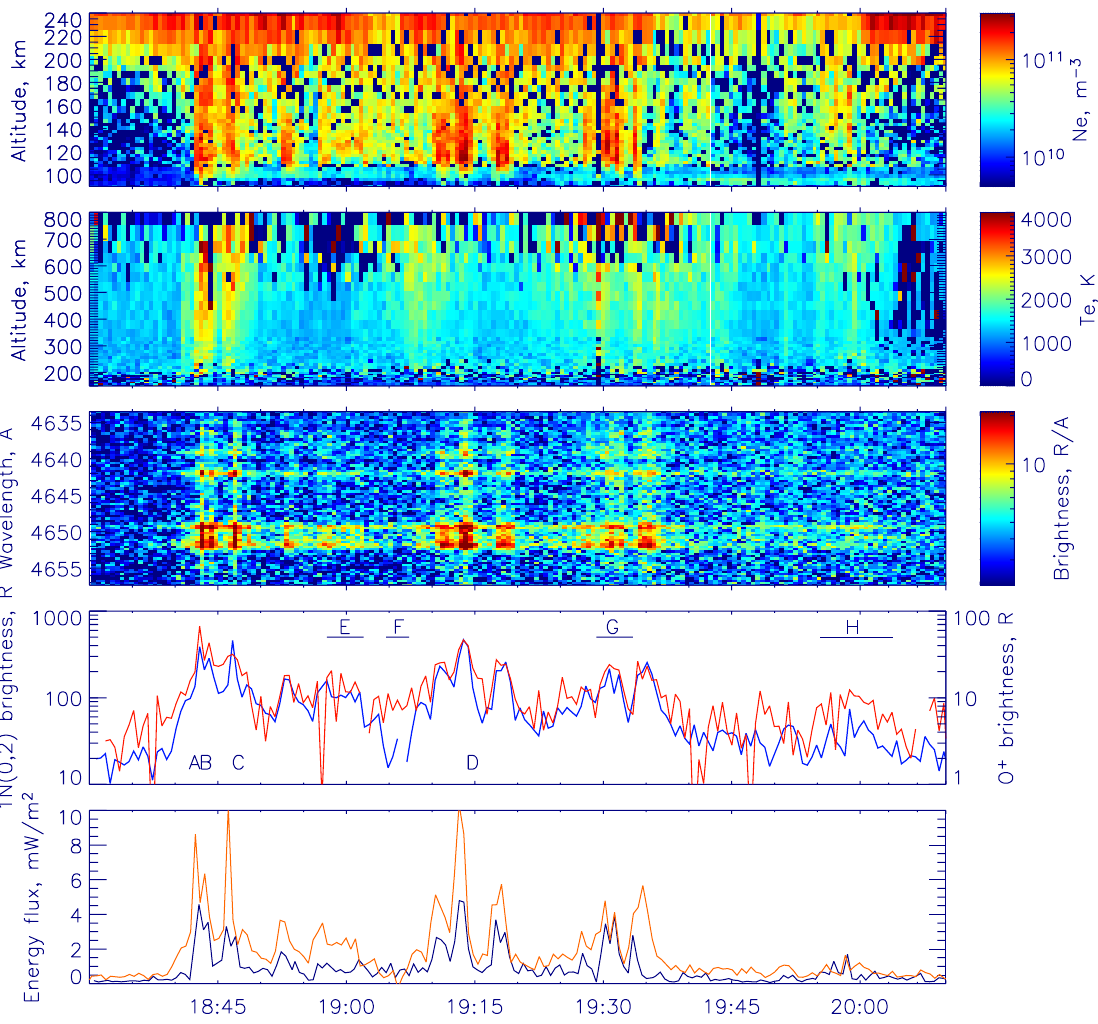
Fig. 10. The event of 14 January 2002. Panels from top to bottom: ESR measurement of electron number density in the E-layer, and electron temperature in the F-layer; time evolution of 1N(1,3) spectra recorded by the HiTIES; line plots of N + intensities; precipitating electron energy flux derived from the radar measurements (blue) and from the optical data (orange). See